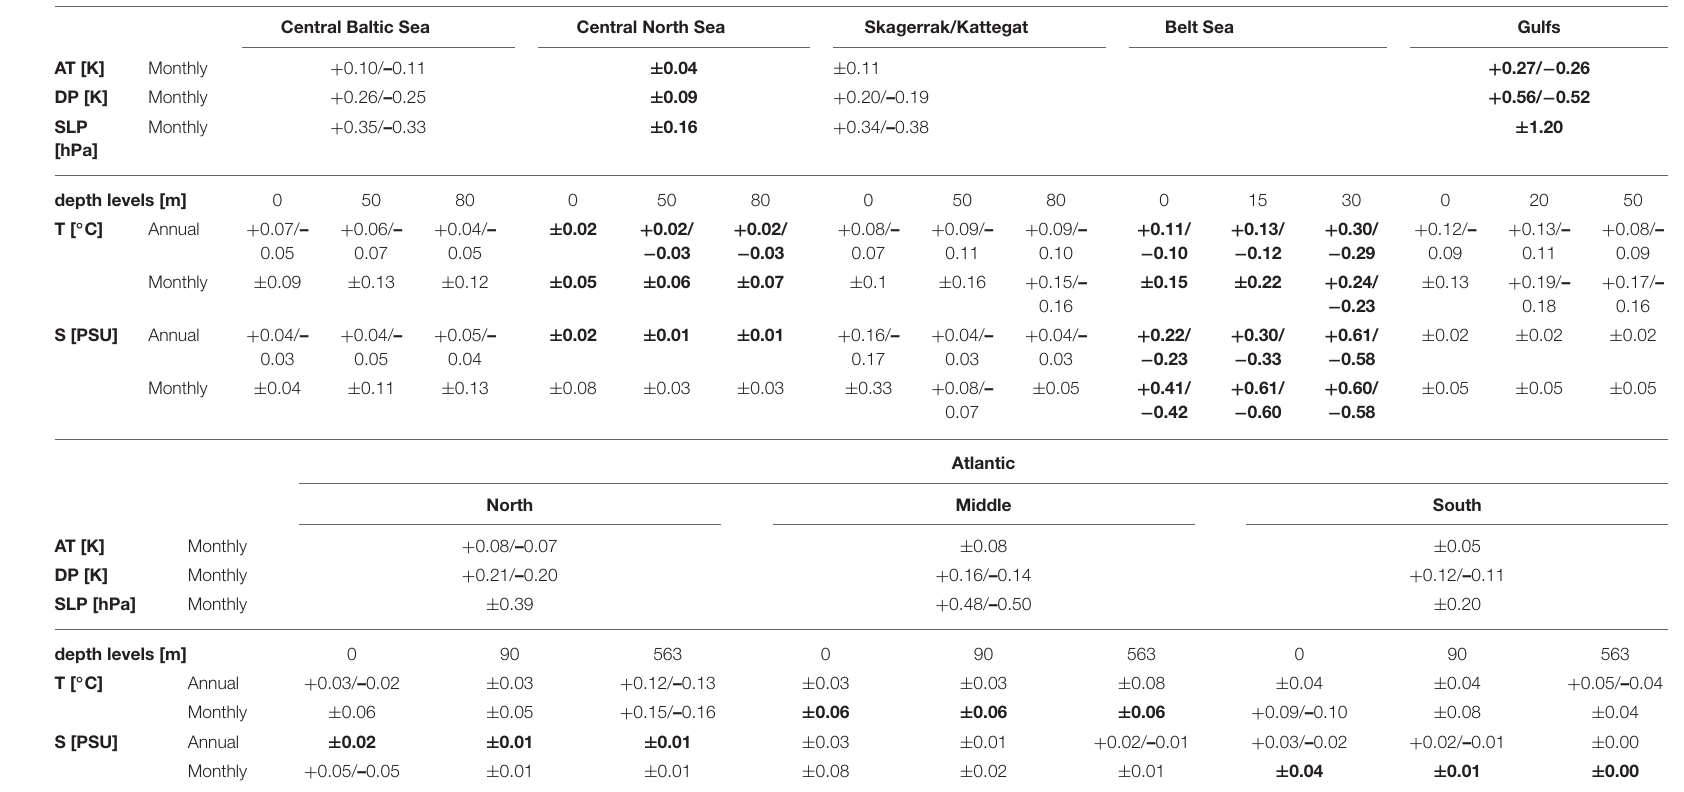
TABLE 3 | Results of the sensitivity study: temporal mean differences between the spatial mean of the reference run (full data collection) and the upper (positive) and lower (negative) envelope formed by the spatial mean of the 100 runs with 90% randomly chosen observations. Central Baltic